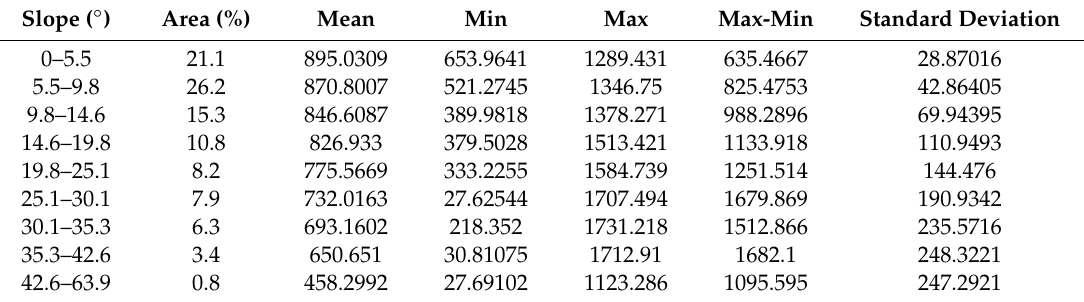
Table 5. Characteristics of the DSSR (W / m 2 ) with the slope at the S2A / B overpass time on